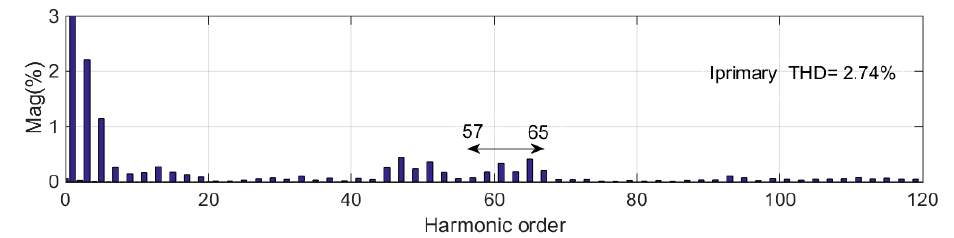
Figure 26. Fourier analysis of transformer primary current.